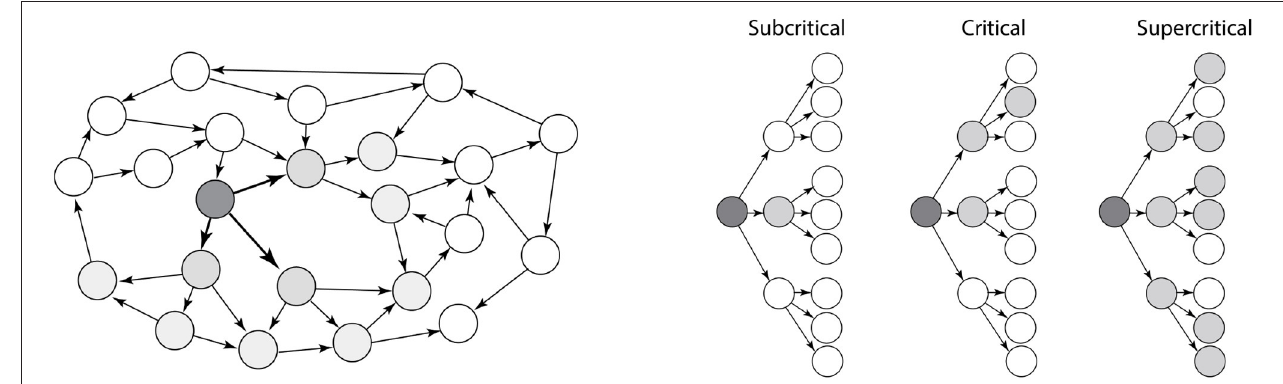
FIGURE 1 | Dynamics of a recurrent excitatory network. (Left) A recurrent excitatory network often has embedded tree-like structures, e.g., the dark nodes. (Right) The stability of networks with tree-like structure are more simple to characterize. They are either subcritical (left), critical (middle), or supercritical (right). Activity in supercritical networks are unstable and will activate the entire network as exponential growth, whereas the activity in subcritical networks will decay exponentially. Adapted with permission from Larremore et al. (2014).